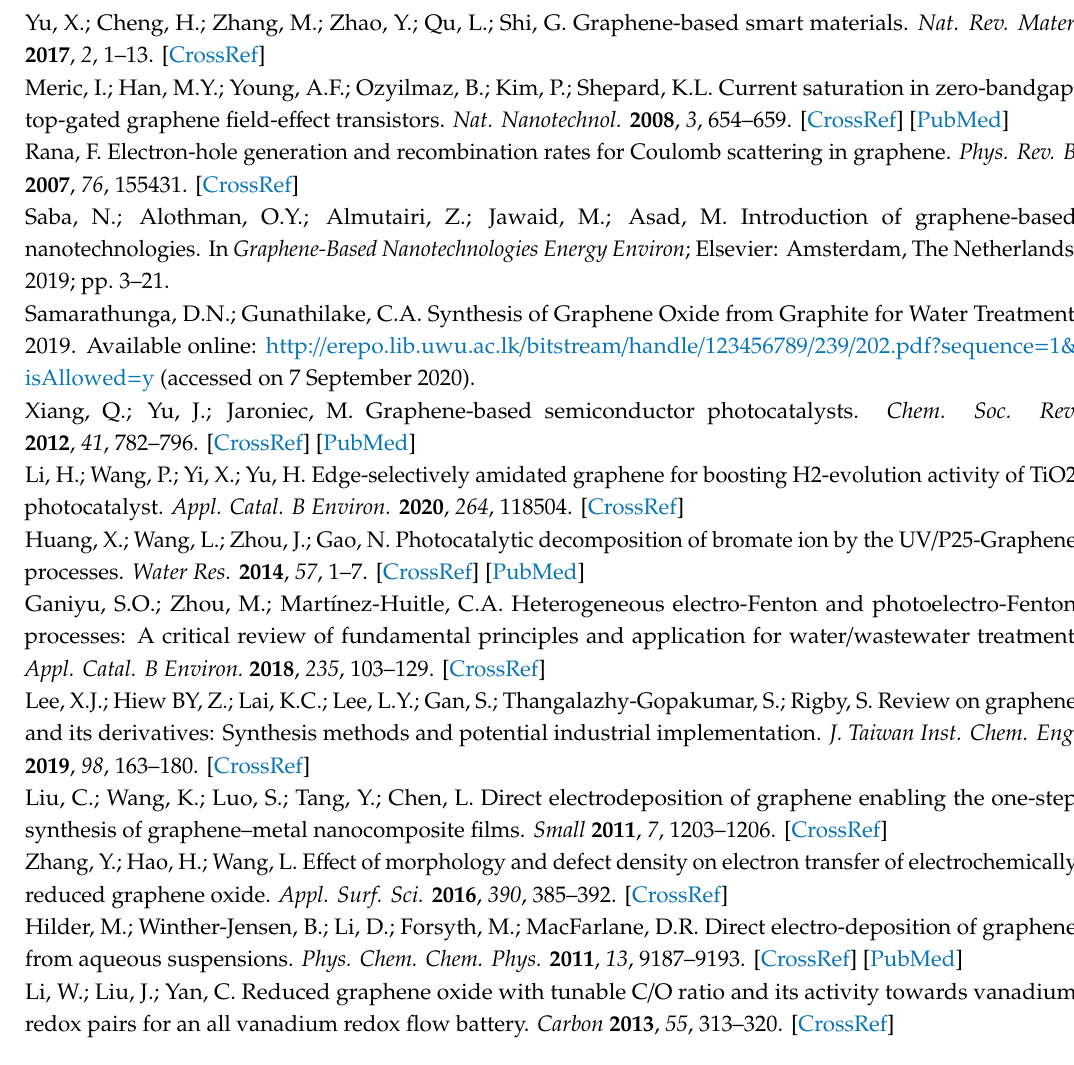
Figure S1. SEM-EDS mapping of synthesized electrodes. Figure S2. Residual plot for studentized